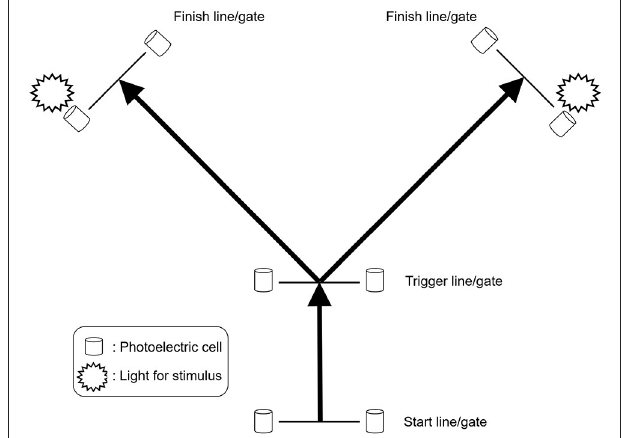
FIGURE 1 | The procedure of the T -Test. The subjects perform i) forward sprinting from (A) to (B) , ii) lateral shuffling to the left from (B) to (C) , iii) lateral shuffling to the right from (C) to (D) , iv) lateral shuffling to the left from (D) to (B) , and v) backpedaling to the finish-position from (B) to (A) . The CODS performance is assessed by time to complete the task (i-v).